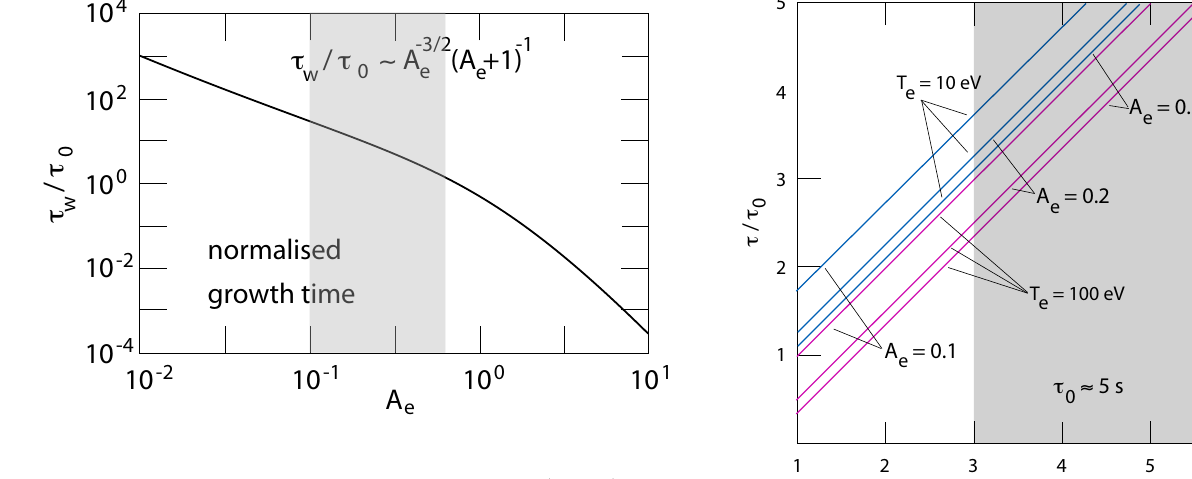
Fig. 4. Variation of the relevant growth times τ W , m (Eq. 18) of the maximum growing Weibel mode with thermal anisotropy A for maximum growth. The normalisation τ 0 is a number which depends on T e ,N e and the value of the final magnetic field strength required for onset of reconnection. In the geomagnetic tail current sheet τ 0 & 0 . 1s. Even though the initial thermal level in Fig. 2 decreases with anisotropy, the times to reach a substantial Weibel field strength in the current sheet are mainly determined by the dependence of the maximum growth rate γ m on A . They depend only logarithmically on the initial thermal wave field. They thus decrease with growing anisotropy. The shaded area shows the range of anisotropies and growth times expected in the geomagnetic tail current sheet.